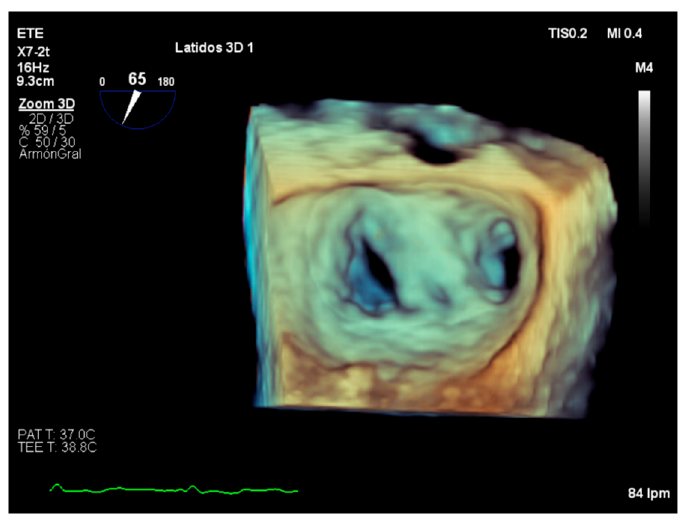
Figure 5. 3D transesophageal echocardiography. Clips placed on the mitral valve after transcatheter edge-to-edge repair procedure.